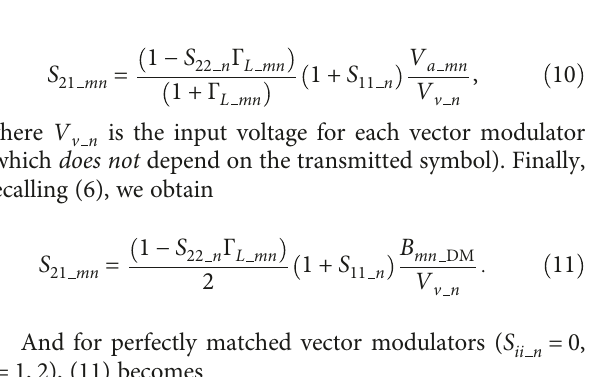
Figure 7: Magnitude of radiation patterns that transmit a 16-QAM constellation at 60 ° ( PE vector modulators. (a) Ideal components. (b) Real